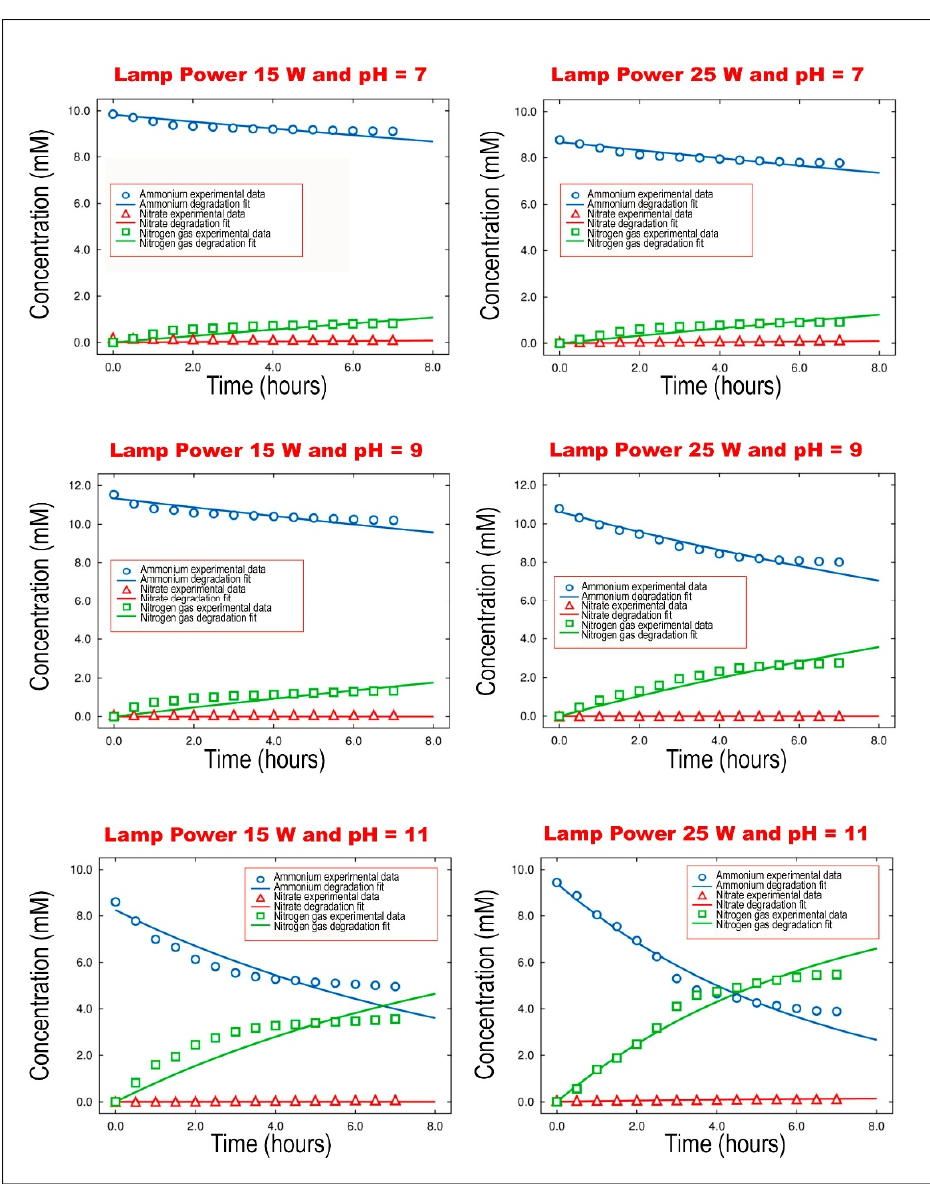
Figure 14. Simultaneous fits of 3 sets of C ( t ) data to the corresponding 3 differential rate equations according to the proposed two parallel reaction mechanism for NH 4+ /NH 3 degradation by photolysis and photocatalysis, at two lamp irradiation powers and different pHs, Q = 1000 L/h, temperature = 20 ± 1 ◦ C. Table 2. Values of the rate constants for the disappearance of ammonium/ammonia ( k 3 ) and the appearance of nitrate ( k 1 ) and nitrogen gas ( k 2 ), obtained by simultaneous fits of the three differential equations proposed to the corresponding sets of experimental C ( t )